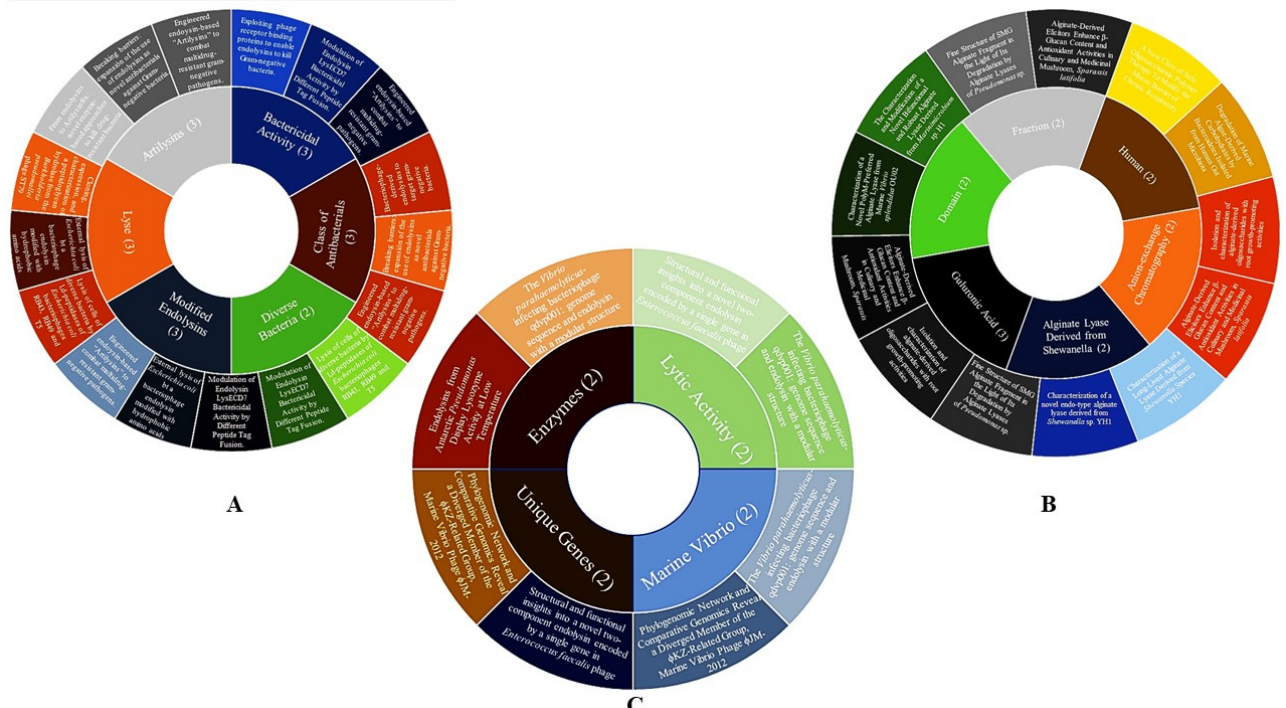
Figure 5. Trends of central themes of this review: ( A ) Endolysins directed towards G-antibiotic- resistant bacteria; ( B ) Use of OSA as an antibacterial agent in marine bacteria; ( C ) Endolysins target- ing marine